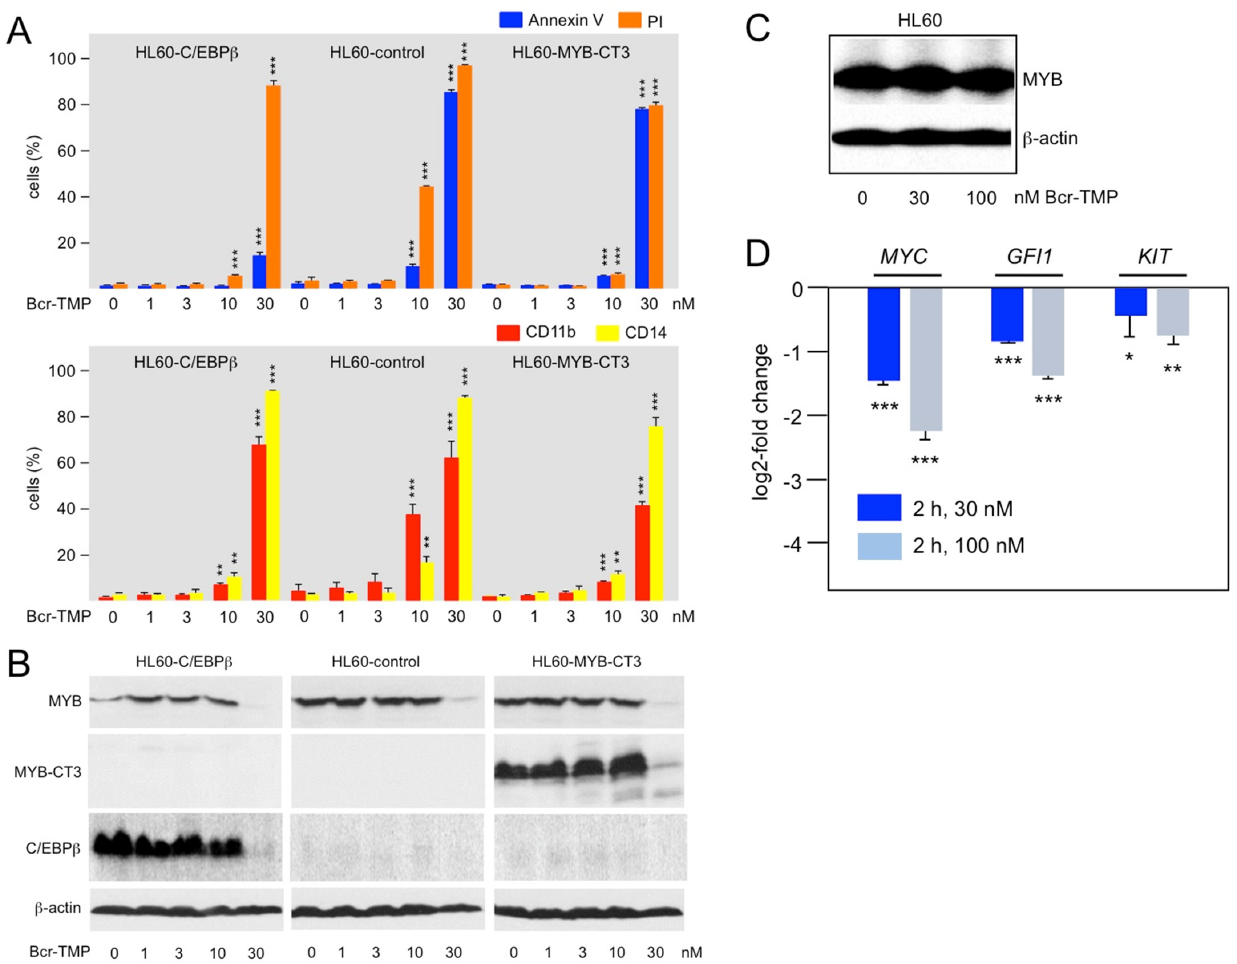
Figure 4. Bcr-TMP suppresses AML cells in a MYB-dependent manner: ( A ) HL60 cells infected with a control lentivirus (HL60-control) or a lentivirus encoding C-terminally truncated MYB (HL60-CT3) or C/EBP β (HL60-C/EBP β ) were treated for 72 h with the indicated concentrations of Bcr-TMP, followed by staining with annexin V and propidium iodide (top) or antibodies against CD11b and CD14 (bottom) and analysis by flow cytometry. ( B ) Western blot analysis of MYB and C/EBP β expression of the cells treated as in panel A. ( C , D ) HL60 cells treated for 2 h with 30 or 100 nM Bcr-TMP. The cells were the analyzed by Western blotting for MYB and β -actin expression ( C ) and by RT-PCR analysis for MYC , GFI1 and KIT mRNA expression ( D ). Asterisks indicate statistical significance (* p < 0.05; ** p < 0.01, *** p < 0.001, Student’s t -test). The uncropped Western blots have been shown in Figure